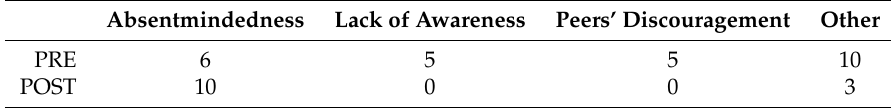
Table 5. Contingency table of MPH: PRE vs. POST in overall barriers to behave energy efficiently. Absentmindedness Lack of Awareness Peers’ Discouragement Other PRE 6 5 5 10 POST 10